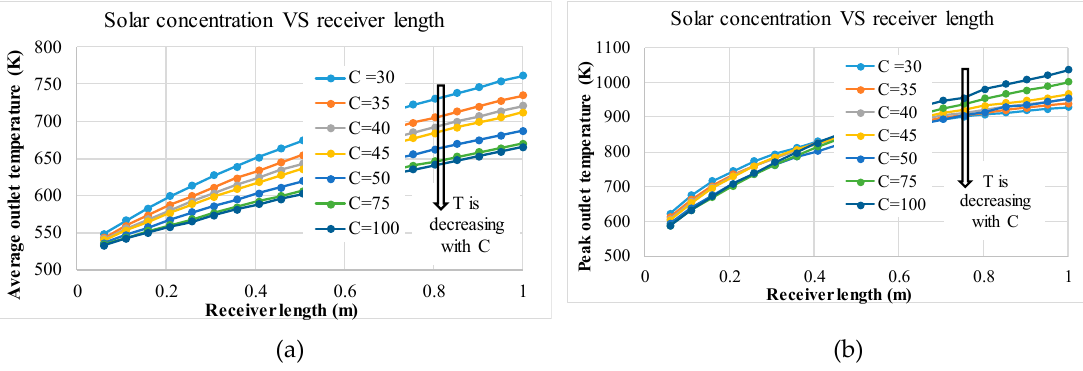
Figure 19. ( a ) Average and ( b ) peak temperatures of the receiver at different receiver lengths and solar concentrations. (In the Figure, T and C are the Kelvin temperature and solar concentration respectively).